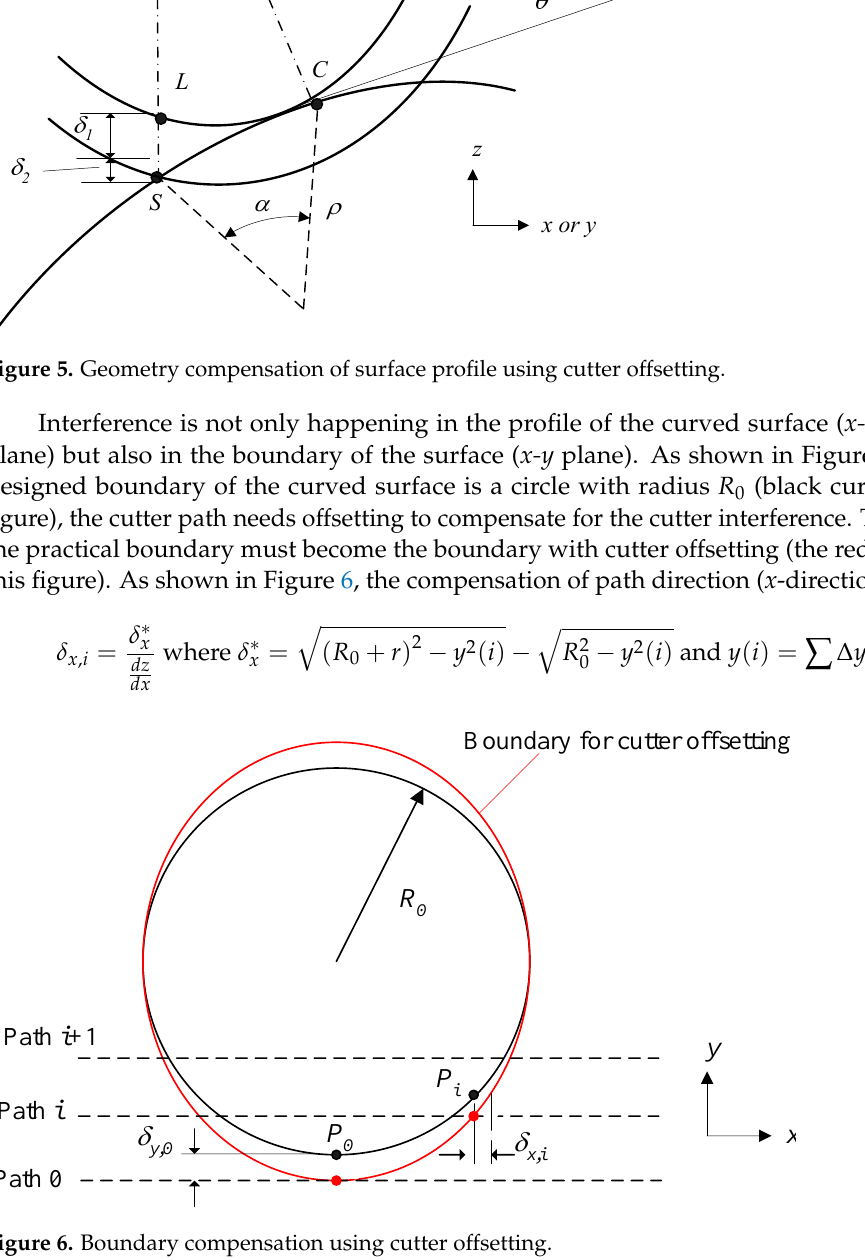
Figure 6. Boundary compensation using cutter offsetting.